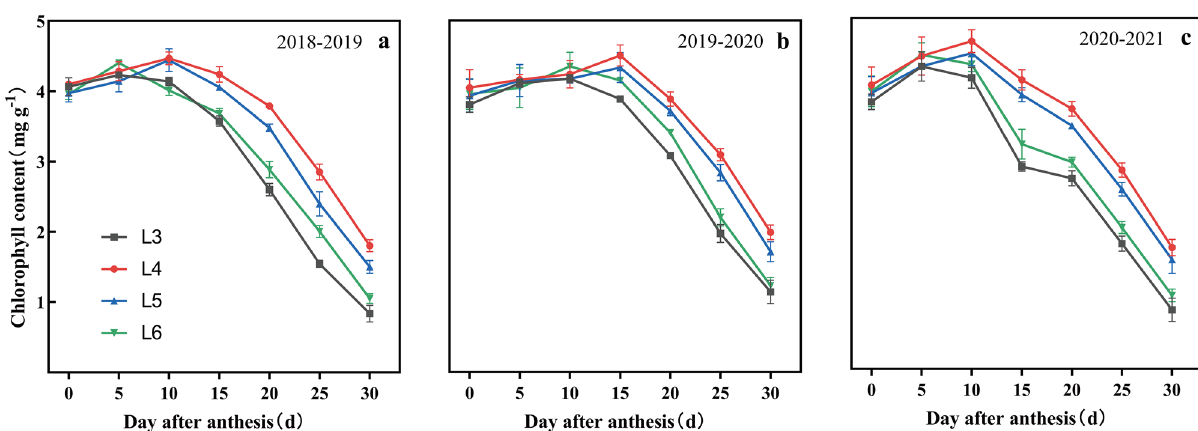
Figure 9. Effects of irrigation time on chlorophyll content of flag leaves in 2018–2019 ( a ), 2019–2020 ( b ) and 2020–2021 ( c ). Vertical bars represent standard